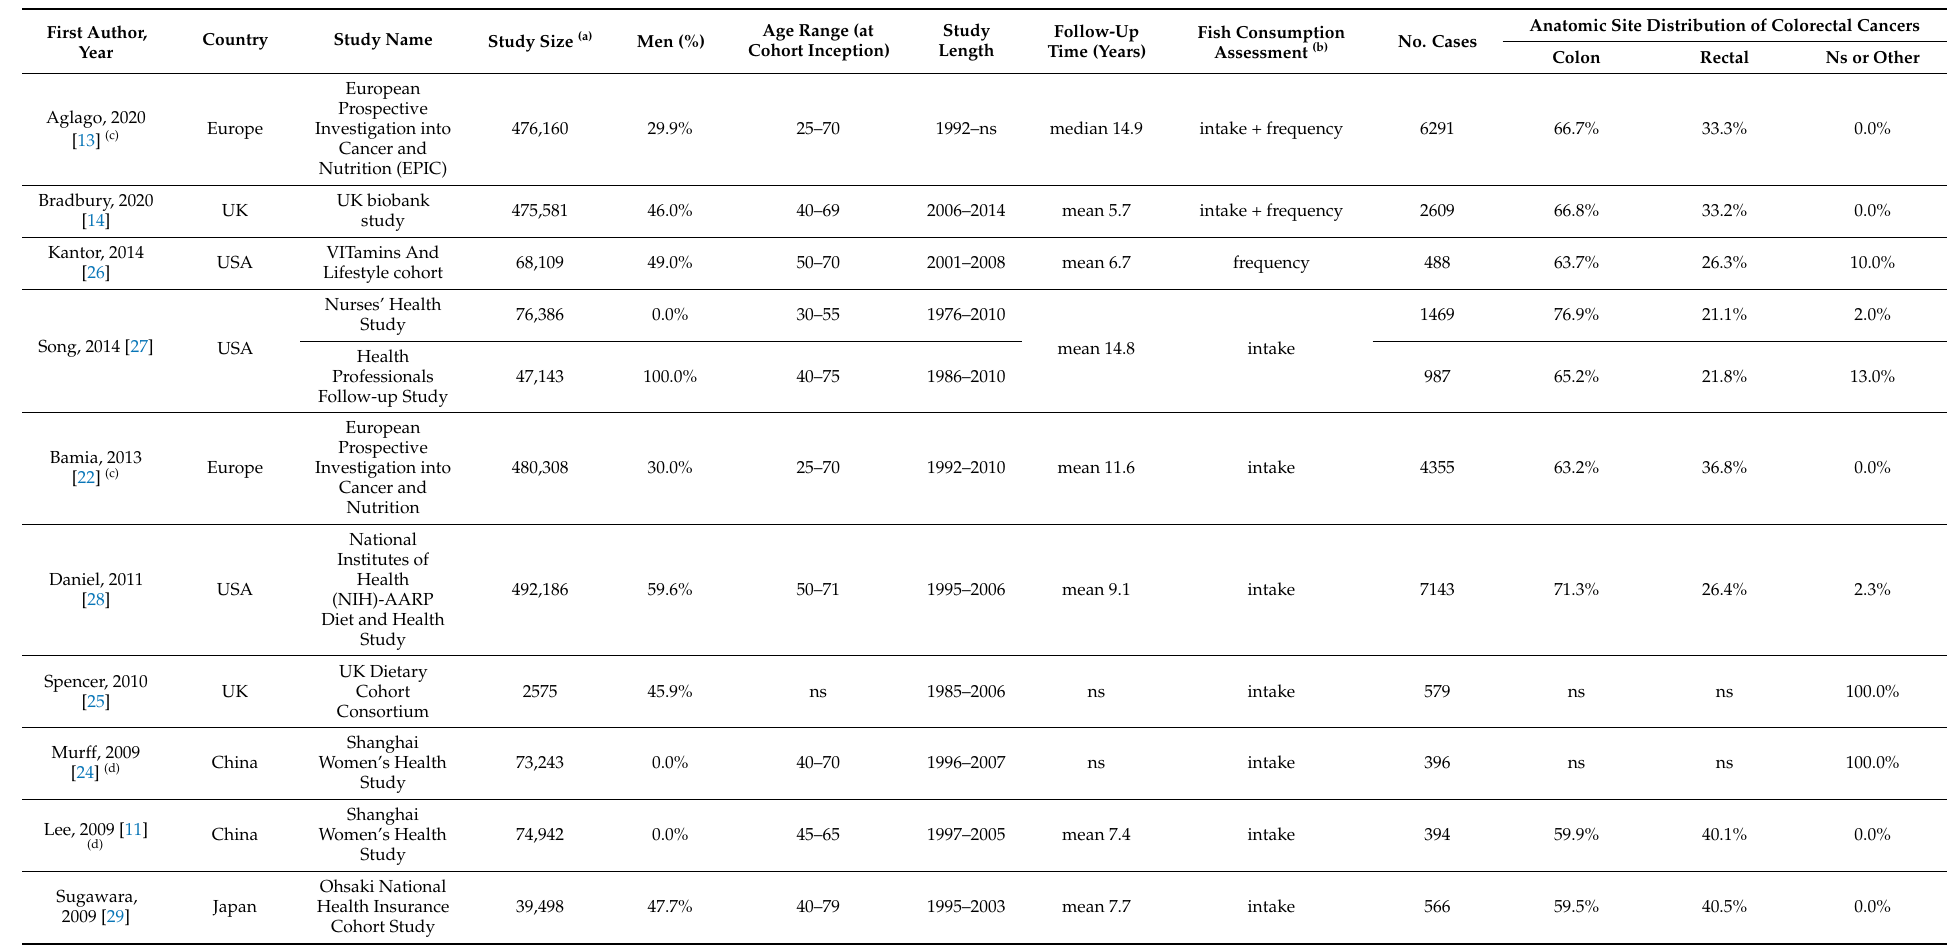
Table 1. Main characteristics of articles included in the systematic review and meta-analysis on the association between fish consumption and colorectal cancer